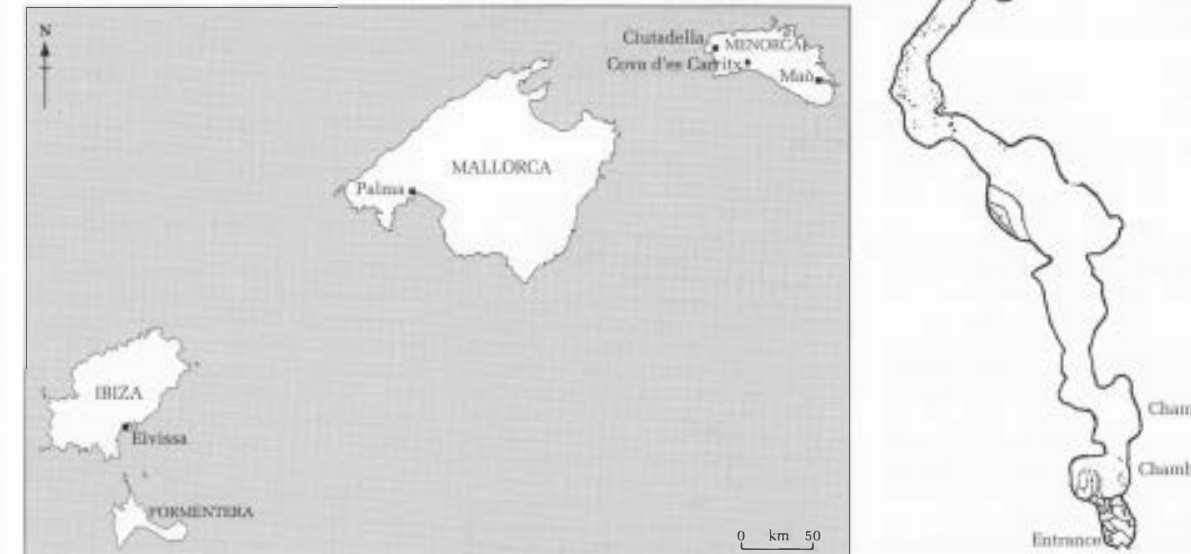
Figure 1 The Balearic Islands, showing the location of Cava d'es Carritx on Menorca. Figure 2 Provisional plan of Cava